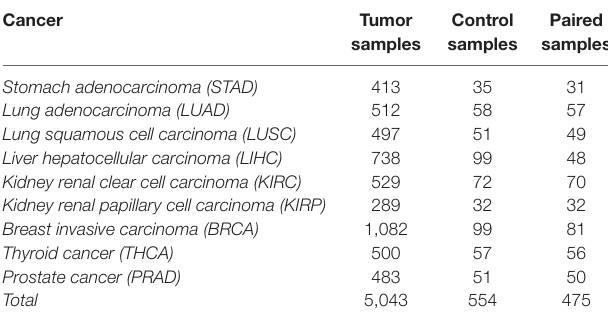
TABLE 1 | Number of tumor, control, and paired samples for nine different cancer types in The Cancer Genome Atlas (TCGA)